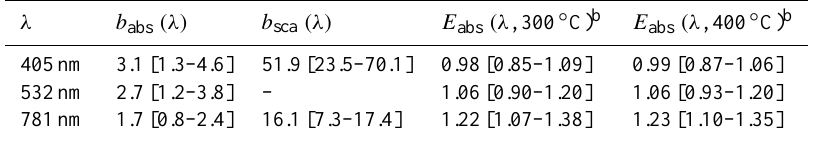
Table 1. Average values of absorption and scattering coefficients (Mm − 1 ) and enhancement of absorption during the observation period a . λ